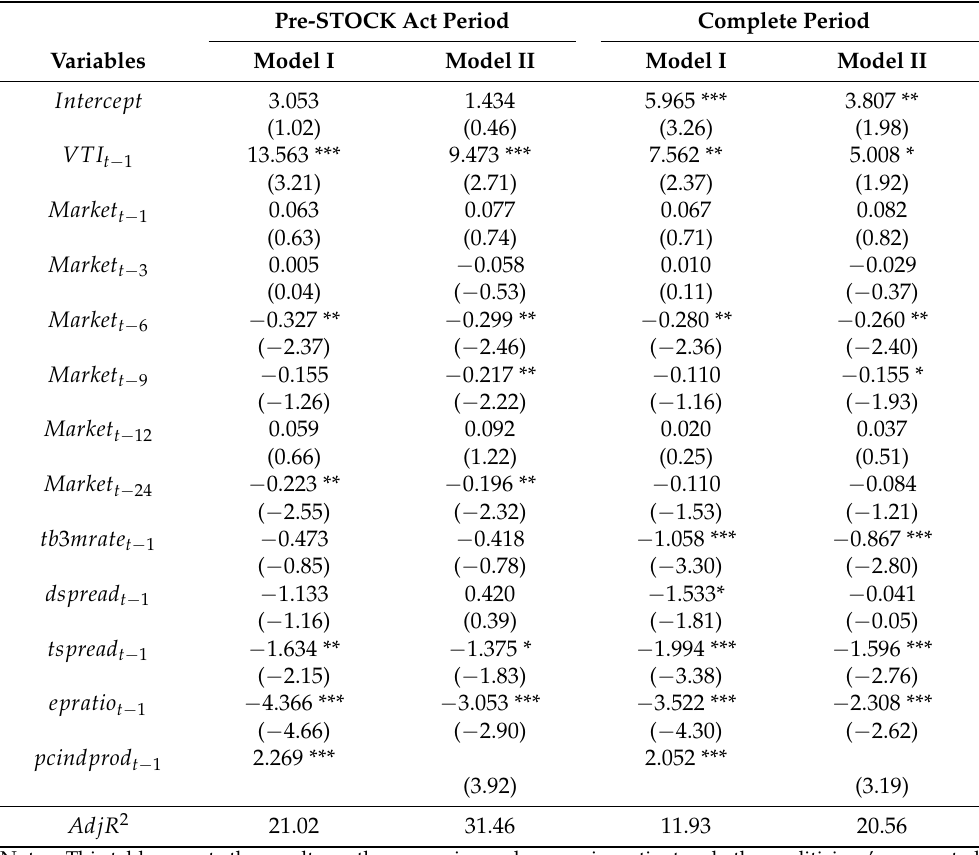
Table 7. Volume-based trading index and value-weighted market